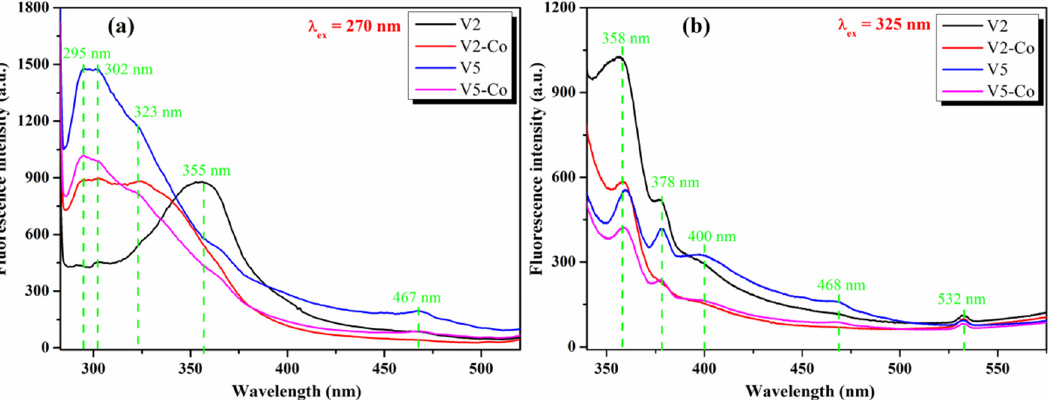
Figure 11. Fluorescence spectra of Co-doped CeO 2 NPs (V2-Co, V5-Co) comparative to pristine V2 and V5 pristine CeO 2 NPs at λ ex = 270 nm ( a ) and λ ex = 325 nm ( b ).